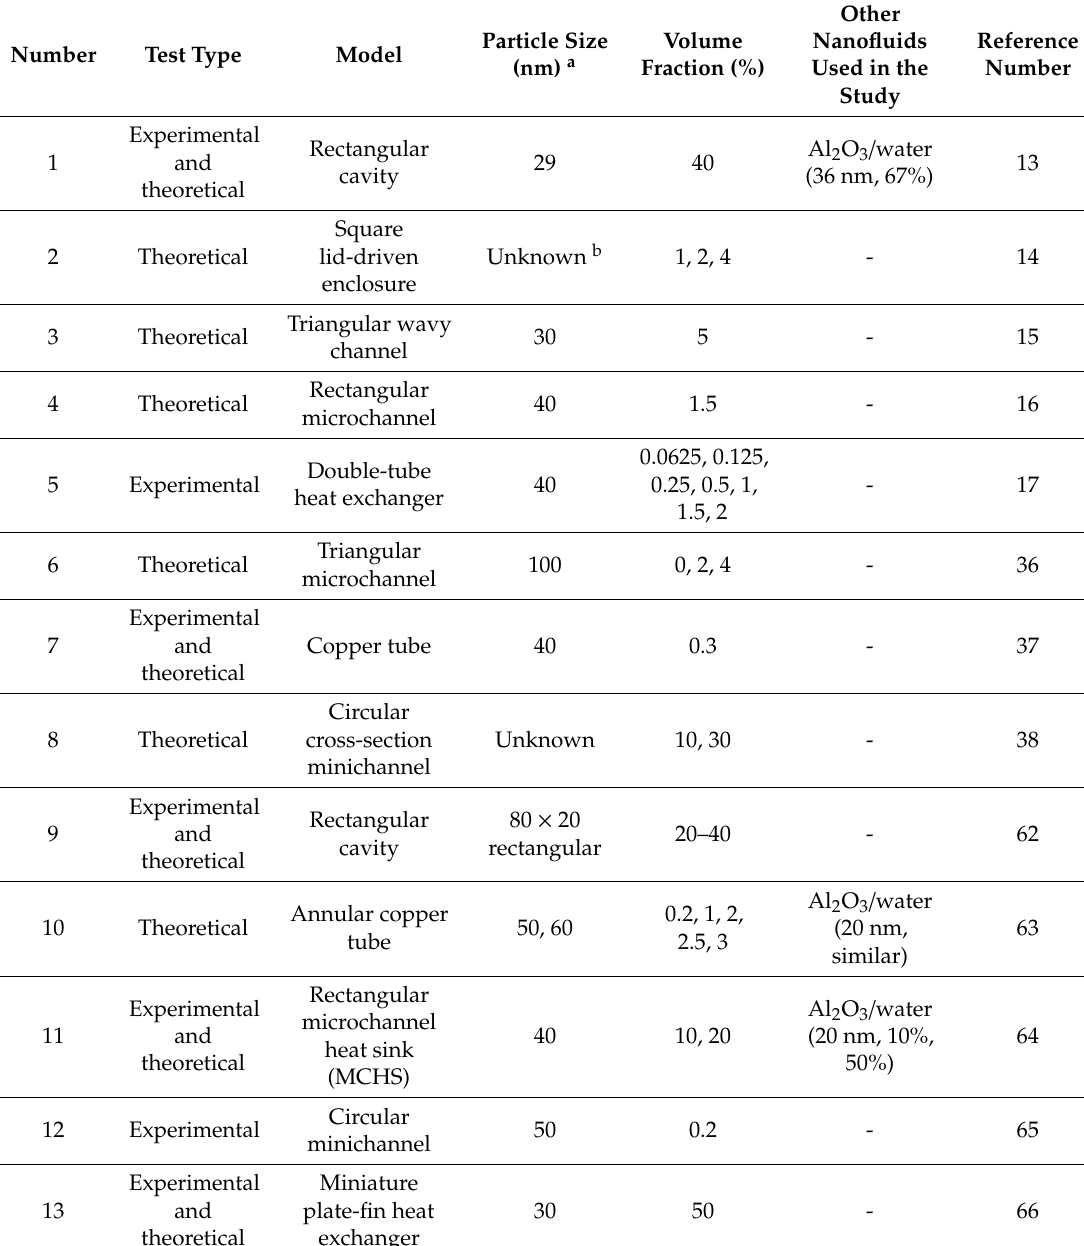
Table 1. Studies that used CuO nanoparticles in base